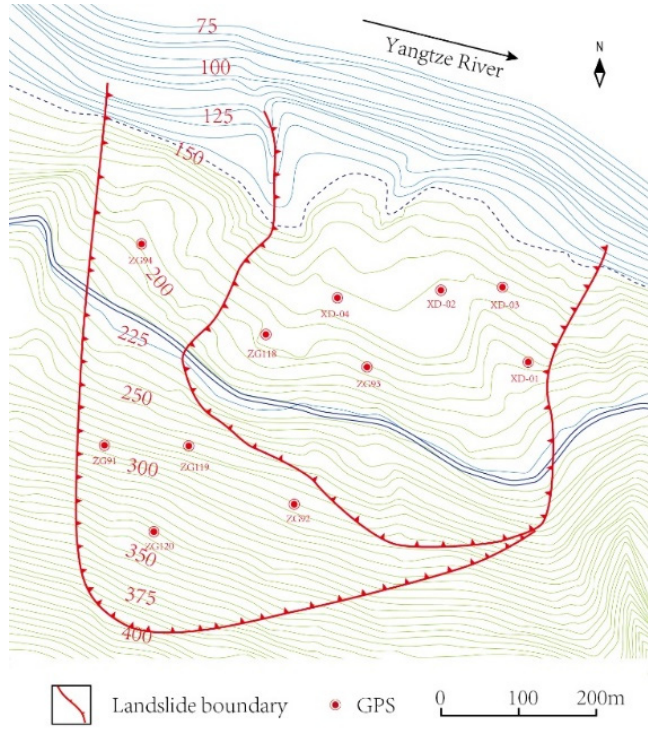
Figure 4. The GPS monitoring location of the Baishuihe landslide area.